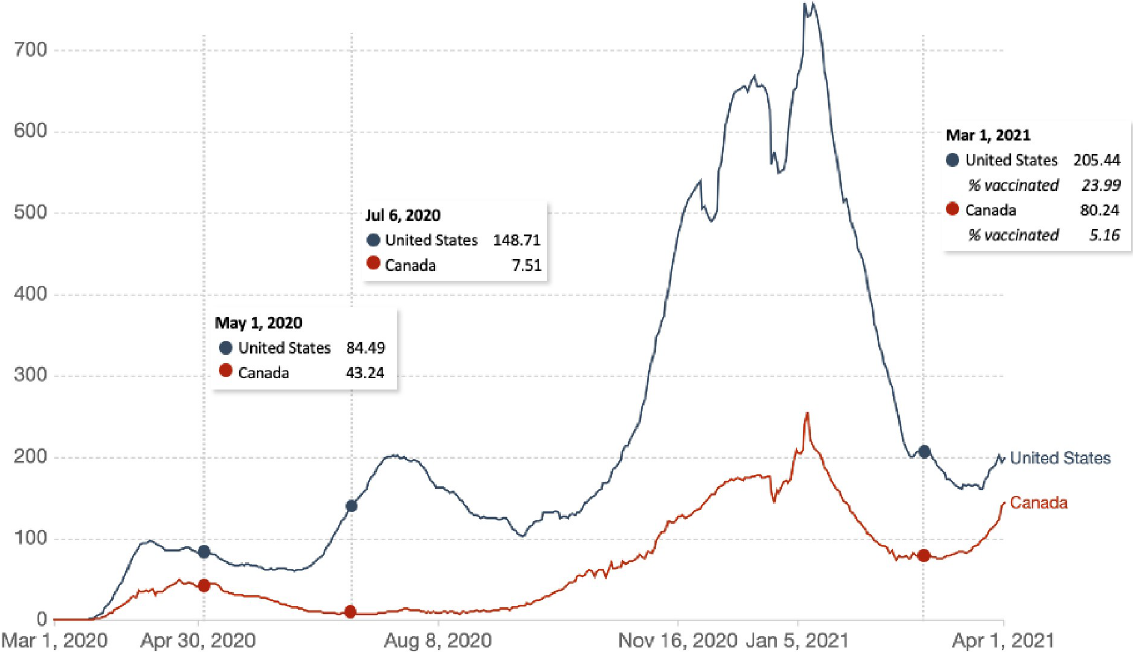
Fig 1. Daily new confirmed COVID-19 cases per million people (rolling 7-day average) in the United States and Canada. The survey data was collected from May 1 to 4, 2020 (n = 1019), July 6 to 10 (n = 3923), and February 12 to March 4, 2021 (n = 2736). Source: COVID-19 Data Repository from the Center for Systems Science and Engineering (CSSE) at Johns Hopkins University via Our World in Data [8].